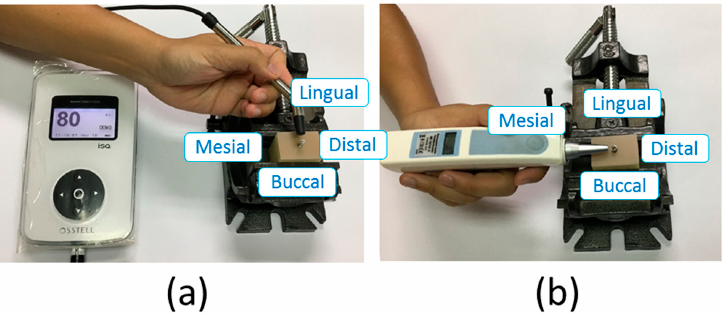
Figure 3. ( a ) Measuring the implant stability quotient (ISQ) by Osstell ISQ device; ( b ) measurement of the Periotest value (PTV) by Periotest